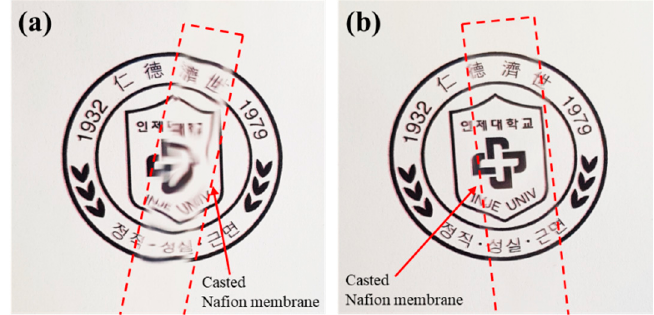
Figure 2. Photographs of Nafion membranes fabricated by ( a ) evaporation method and ( b ) HPTS method.